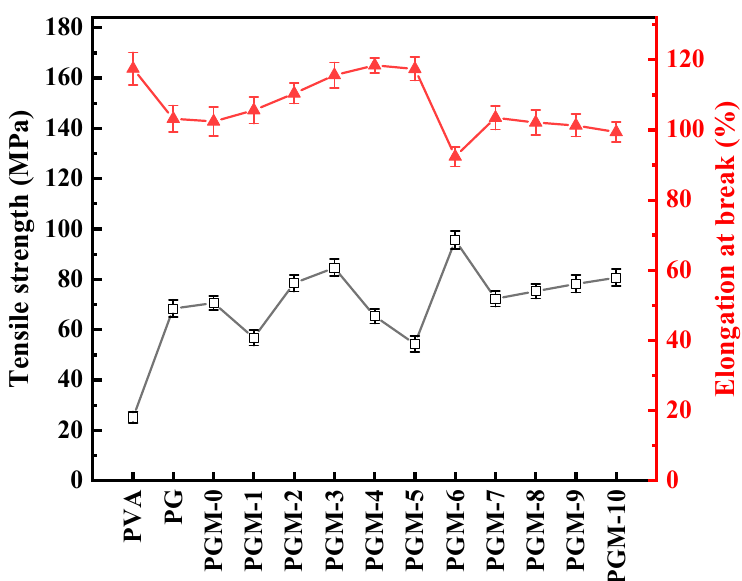
Figure 9. Mechanical properties of the as-prepared membranes.